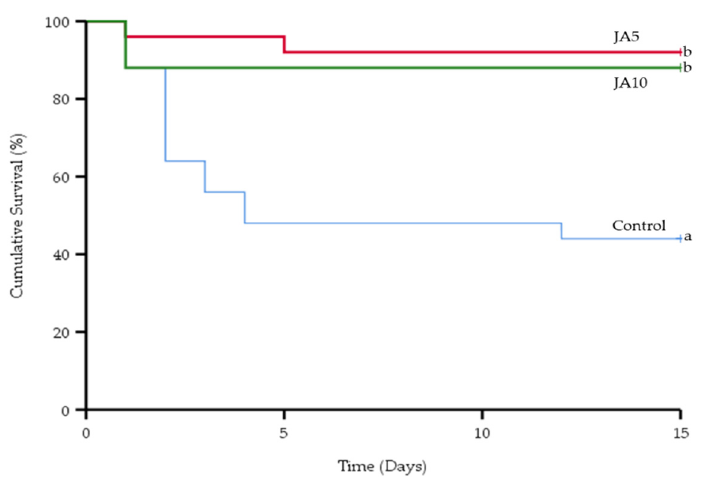
Figure 3. The average cumulative survival rate of red tilapia fed the control diet, JA5-supplemented diet, and JA10-supplemented diet for 4 weeks following Aeromonas veronii challenge. Kaplan-Meier survivorship curves over time (days) for red tilapia were plotted with the log-rank (Mantel-Cox) statistical test to compare the experimental groups. a, b Different superscript letters in each treatment denote statistically significant differences ( p < 0.01). Data represent the means ± SD ( n = 30). The cumulative survival rate was significantly higher in the JA5 and JA10 groups, at 92% and 88%, respectively, when compared with the control (44%). After challenge with A. veronii , red tilapia mortality on day 1 occurred at rates of 12%, 4%, and 12% in the